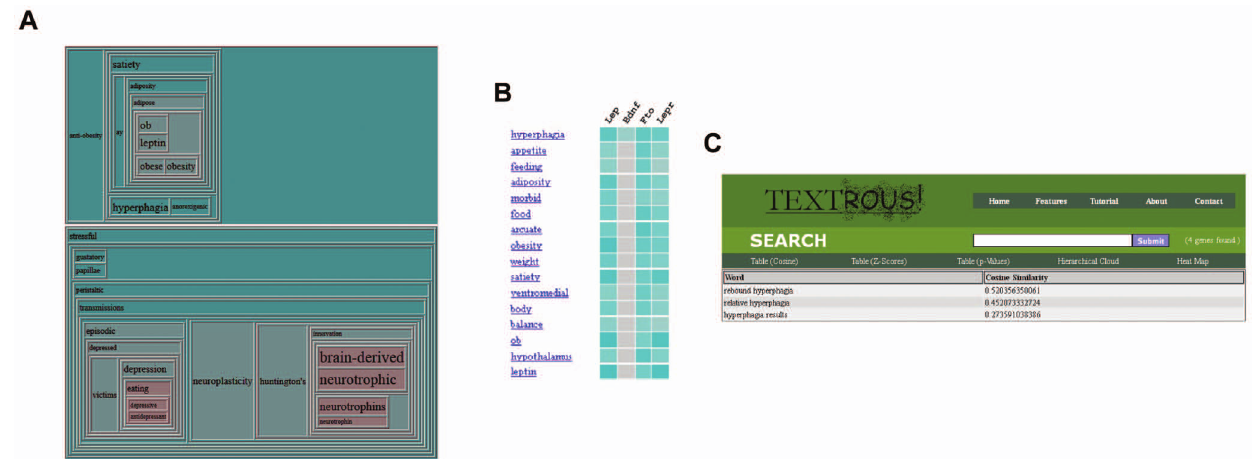
Figure 3. Diverse Textrous! processing formats. (A) An illustration of the hierarchical cloud displaying multiple themes produced by collective processing. The hierarchical cloud shows depression and stress at the conjunction between terms related to the central nervous system and terms related to obesity. Each cell is color-coded to represent the time at which joins were made. Font sizes are adjusted in proportion to the calculated cosine similarities. (B) An illustration of the heat map produced by individual processing. The top associated (Cosine Similarity) terms are shown, as well as the relationships amongst genes. Here, the heat map shows that the top words are obesity-related, and that ‘‘Bdnf’’ is dissimilar to the other genes in the query. Grey color indicates a relative lack of association, while the intensity of teal color corresponds directly to the strength of correlation of each pairwise association. (C) Each of the output textual terms can be hyperlinked, via clicking on the word, to their associated top- scoring (Cosine Similarity) phrases. In this panel the output word term ‘ hyperphagia ’ was linked out to its associated phrase contexts. phrases; and discarding all phrases that cannot be formed by the 12281 words in the term-document matrix. The resulting set of noun-phrases (NP) was used to generate a term-phrase-document matrix, with phrases and words as rows, gene documents as columns, and each cell as the presence of a word or phrase in a document.